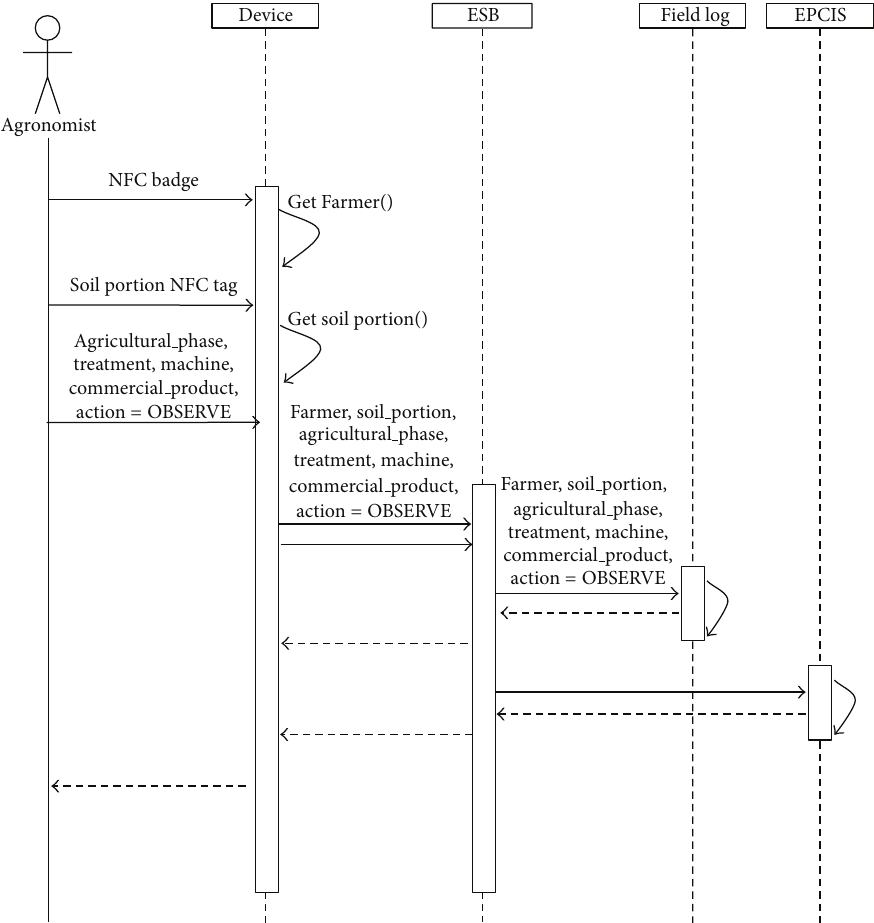
Figure 5: Sequence of interactions between the agronomist and the traceability system when a new observation or treatment is performed in the greenhouse.